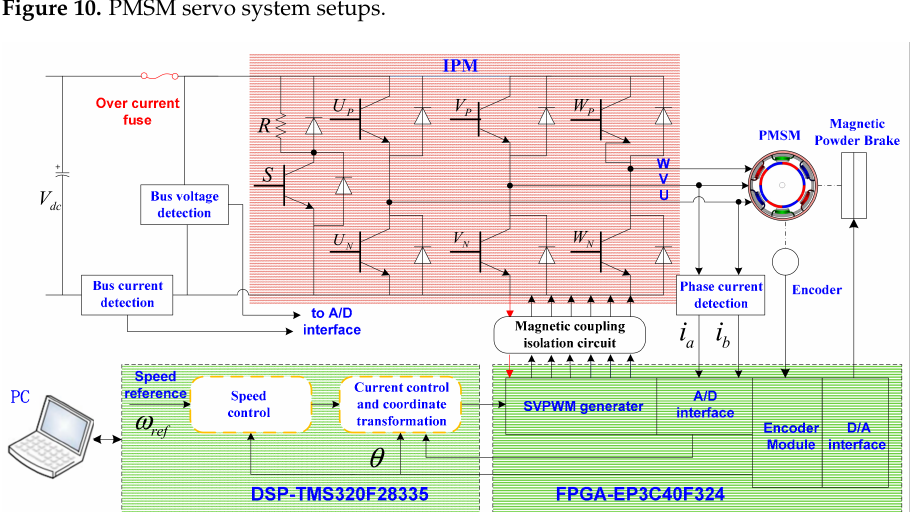
Figure 11. Structural diagram of the PMSM servo